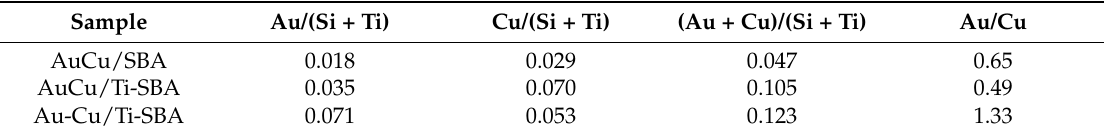
Table 3. X-ray photoelectron spectroscopy (XPS) surface atomic ratios for the prepared samples. Sample Au/(Si + Ti)